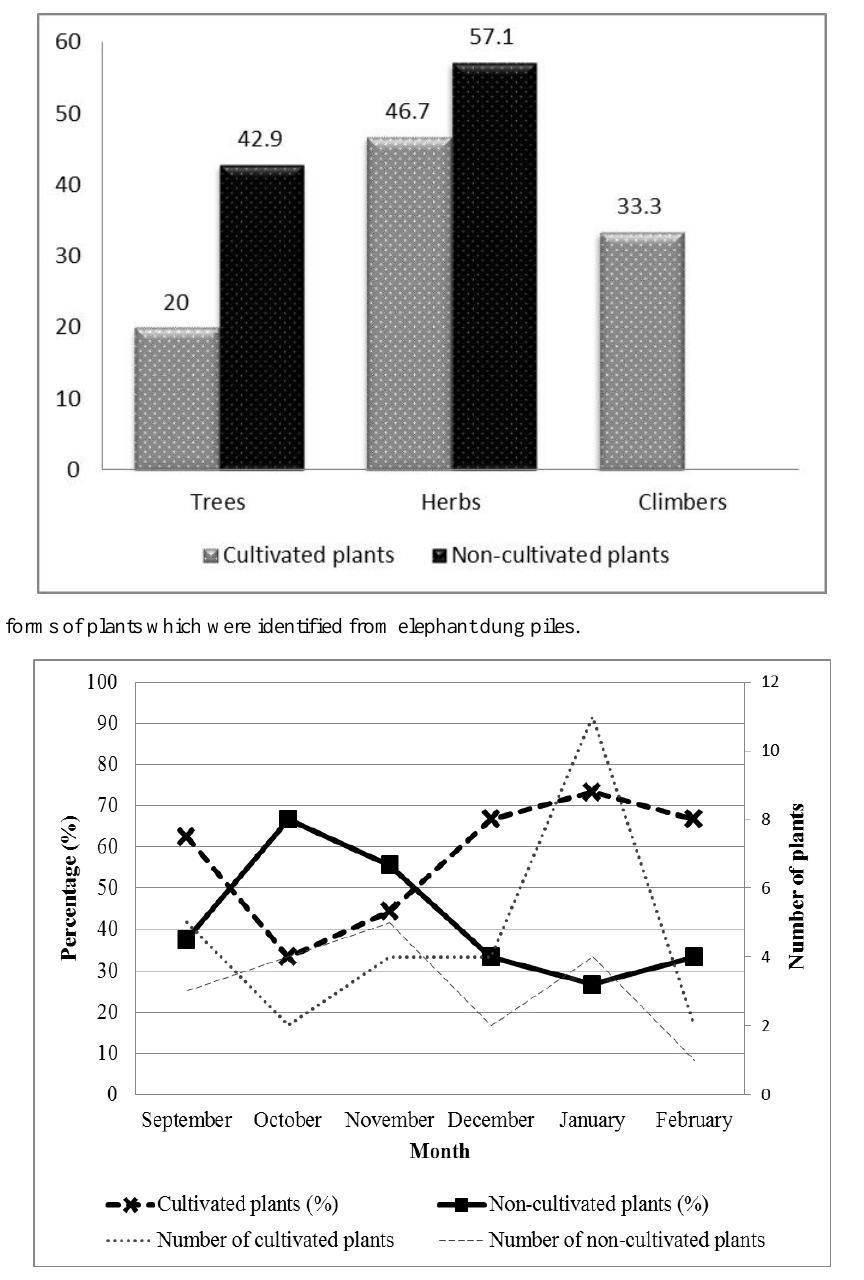
Figure 4: Percentage and number of cultivated and non-cultivated plants which were recorded from dung